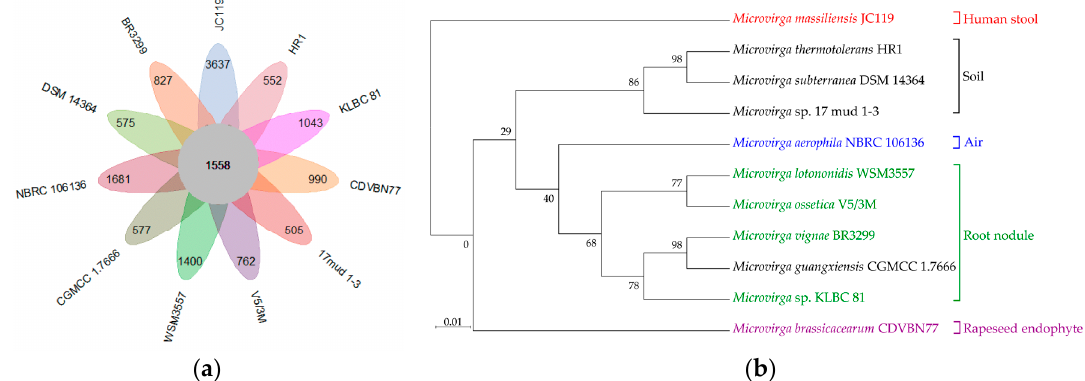
Figure 4. The Pangenome analysis and the genome phylogenetic tree of strains belonging to the Microvirga genus. ( a ) Petal diagram of the pangenome. Each strain is represented by a colored oval. The center is the number of orthologous coding sequences shared by all strains (i.e., the core genome). Numbers in nonoverlapping portions of each oval show the numbers of CDSs unique to each strain. The total numbers of protein-coding genes within each genome are listed in Table 3. ( b ) Groups divided into five groups based on the phylogenetic tree, which is based on 1558 core orthologous proteins of the Microvirga genus. Bootstrap values are expressed as percentages of 1000 replications. Bar: 0.01 substitutions per amino acid.